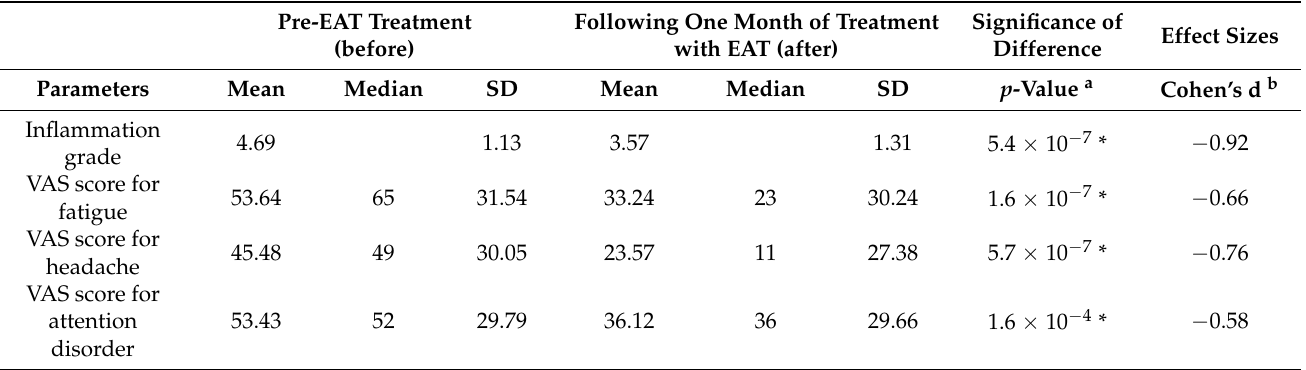
Table 1. The significance of the difference and the effect sizes between pre-epipharyngeal abrasive